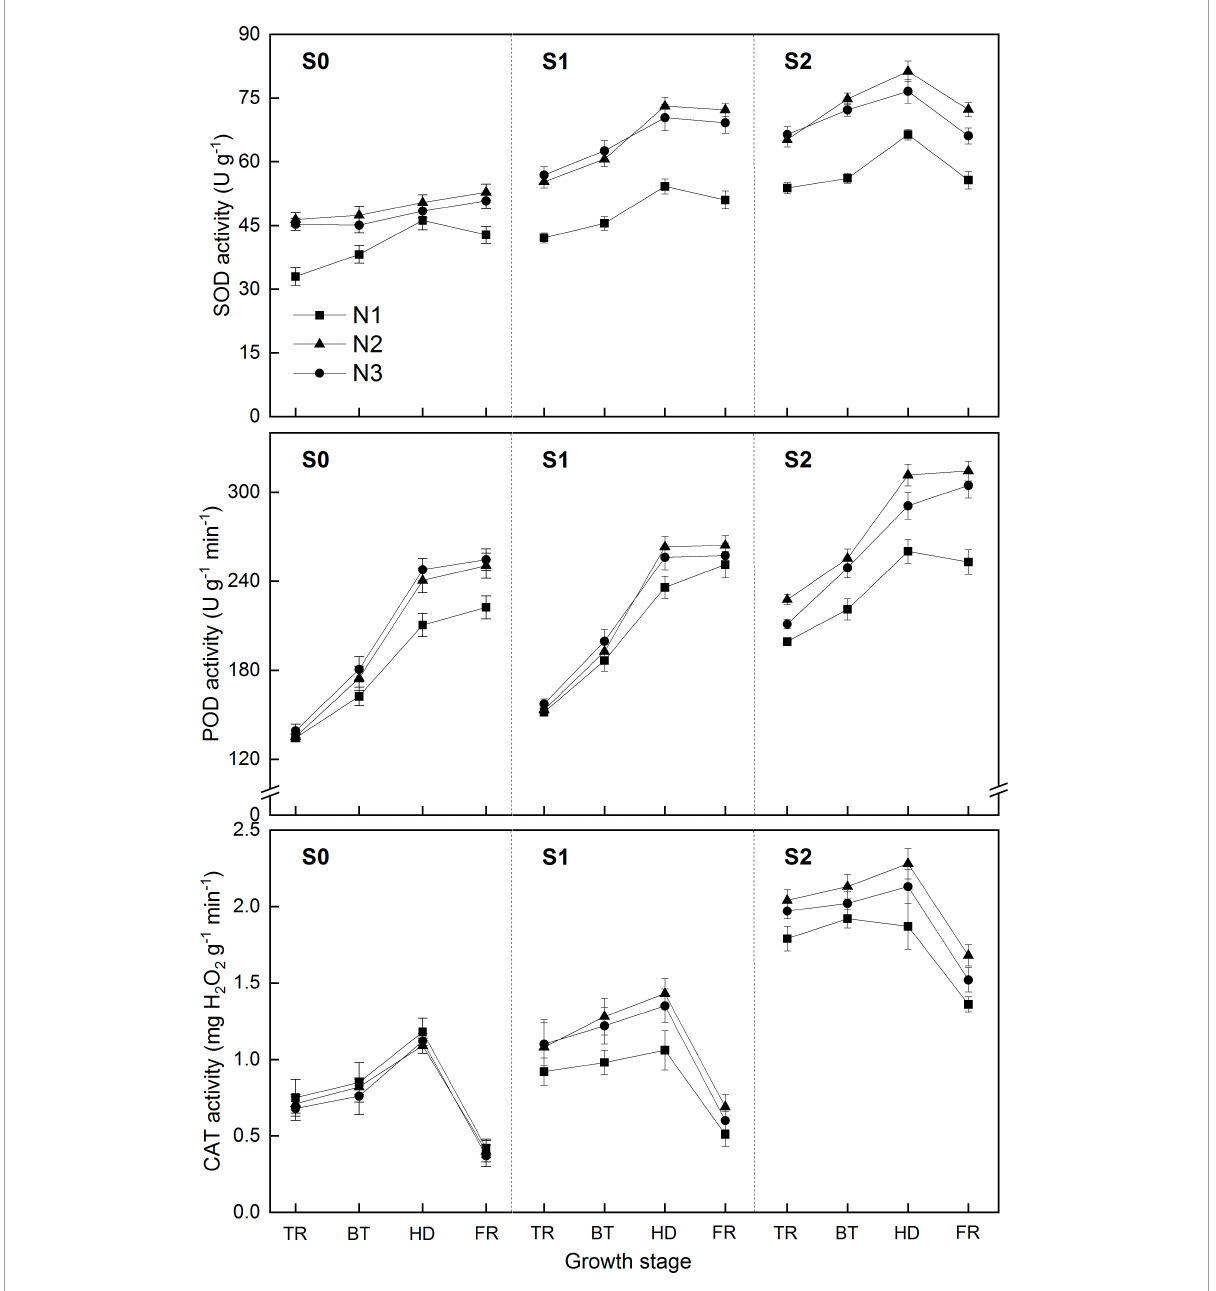
FIGURE4 Effects of different salt concentrations and nitrogen rates on activities of SOD, POD, and CAT in rice root. S 0 , S 1 , and S 2 denote salt concentrations of 0, 1.5, and 3.0 g kg − 1 NaCl, respectively; N1, N2, and N3 denote nitrogen rates of 210, 300, and 390 kg ha − 1 . The data ( n = 3) are mean values ± SD, calculated from three independent experiments. The different letters indicate significant differences at P <